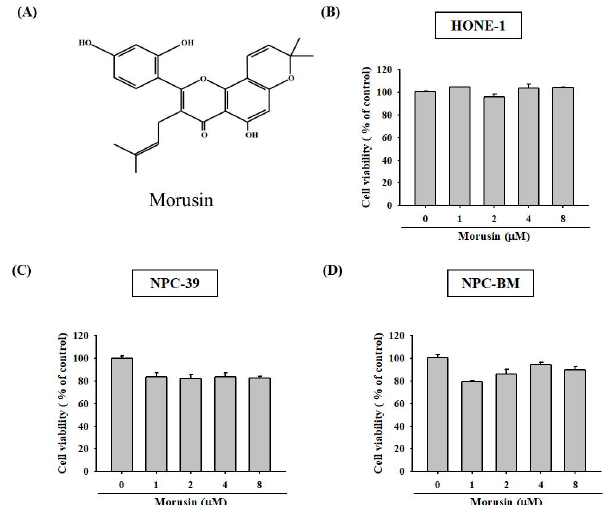
Figure 1. Effect of morusin on cell viability in human NPC cells. ( A ) The chemical structure of morusin. ( B ) HONE-1; ( C ) NPC-39; and ( D ) NPC-BM cells were treated with various concentrations (0–8 µ M) of morusin for 24 h and then examined for cell viability. The data are presented as mean ± SD from at least triplicates independent experiments. Molecules 2020 , 25 , x FOR PEER REVIEW